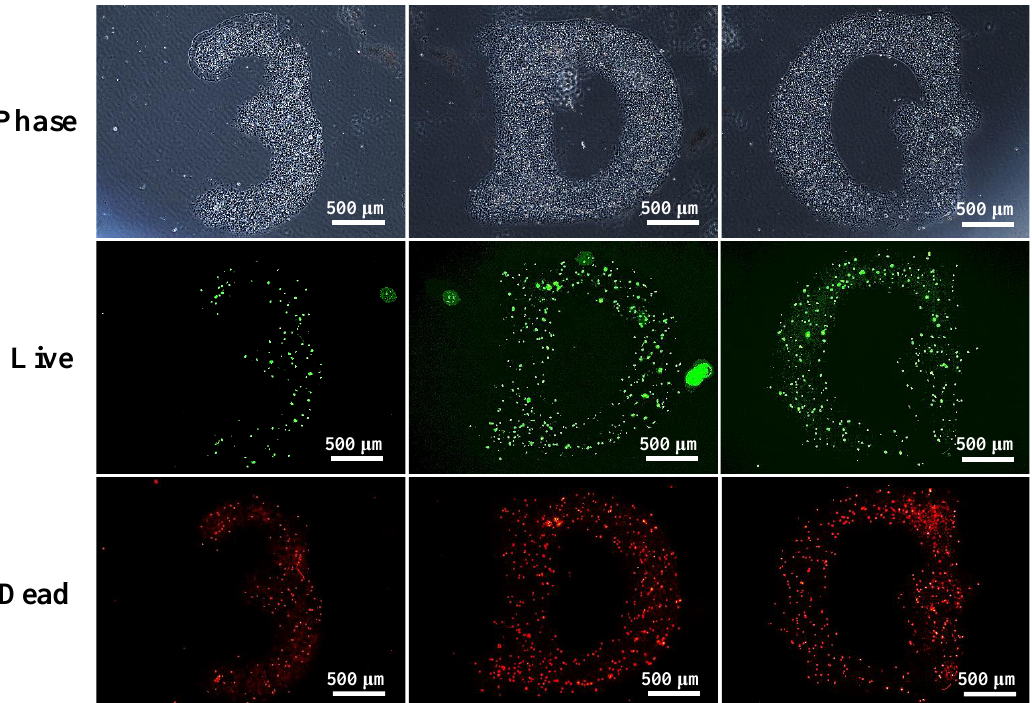
Figure 6. L929 fibroblasts bioprinted with 3BE-3 (Ф 0.13 mm needle head) hydrogel after 24 h.